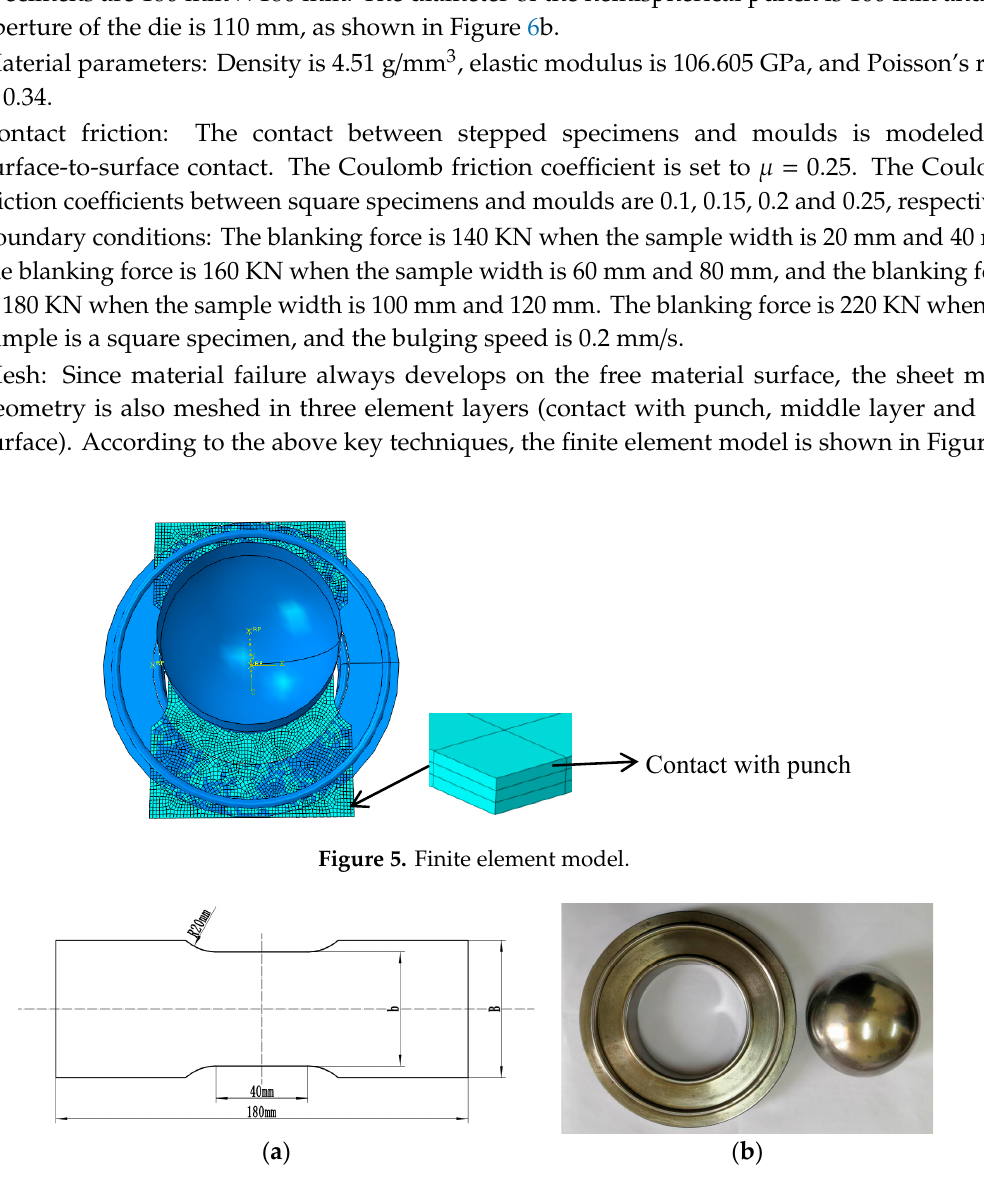
Figure 5. The dimensions of specimens and moulds ( a ) stepped specimen; ( b ) punch and die.